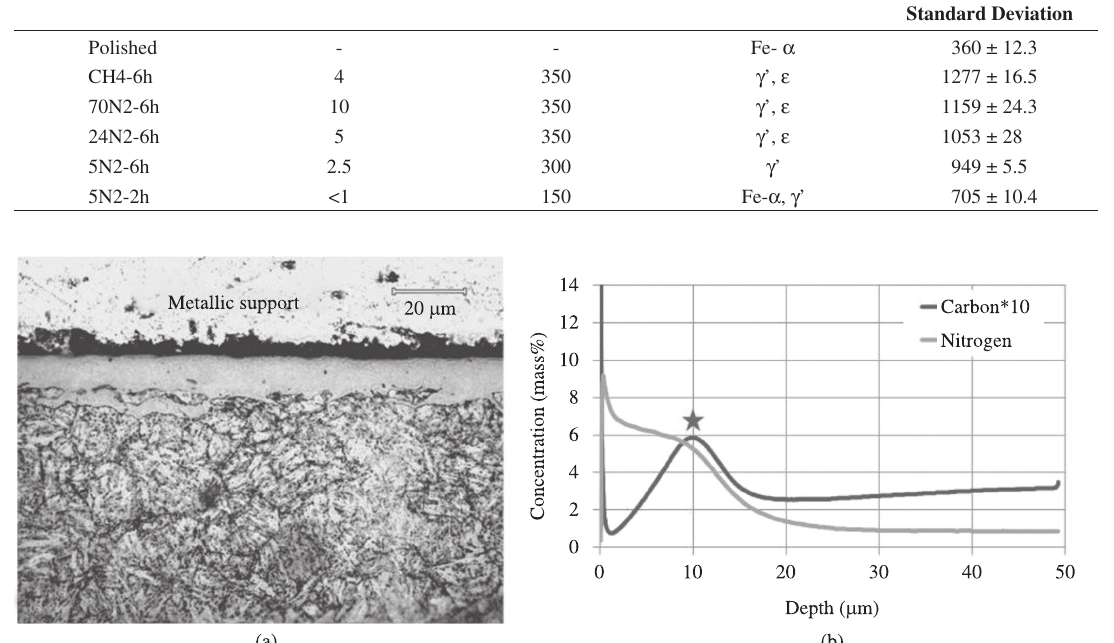
Figure 2. Sample 70N -6h. In (a) photomicrography of the cross section of the sample and in (b) GDOES profile. 2